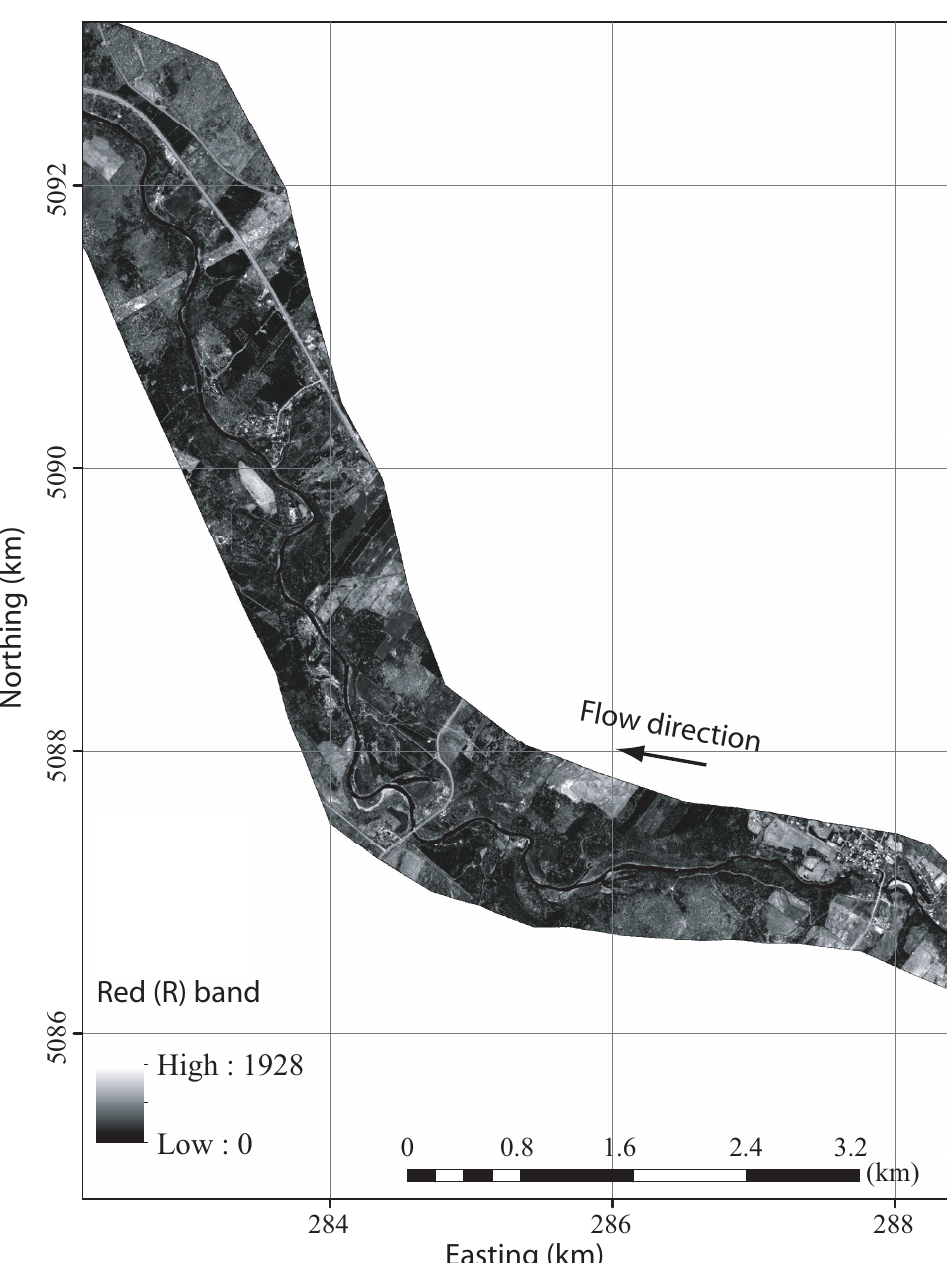
Figure A4. Values of the digital number N (or pixel values) in the red (R) band (Table